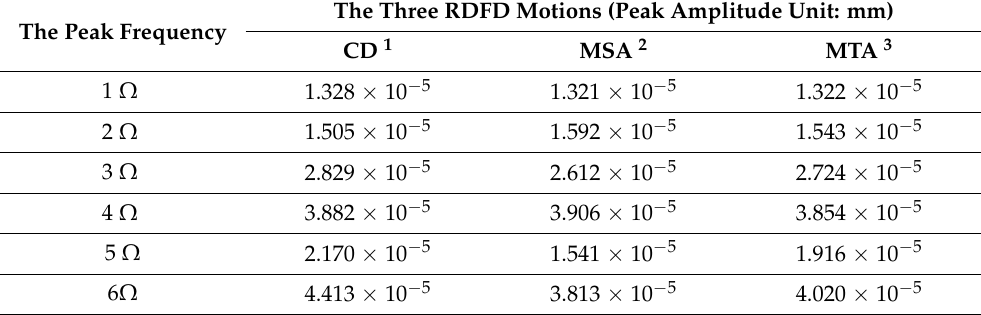
Table 3. The peak amplitudes of the axial vibration spectrum of the follower output node D for the three RDFD motions where Ω = 320